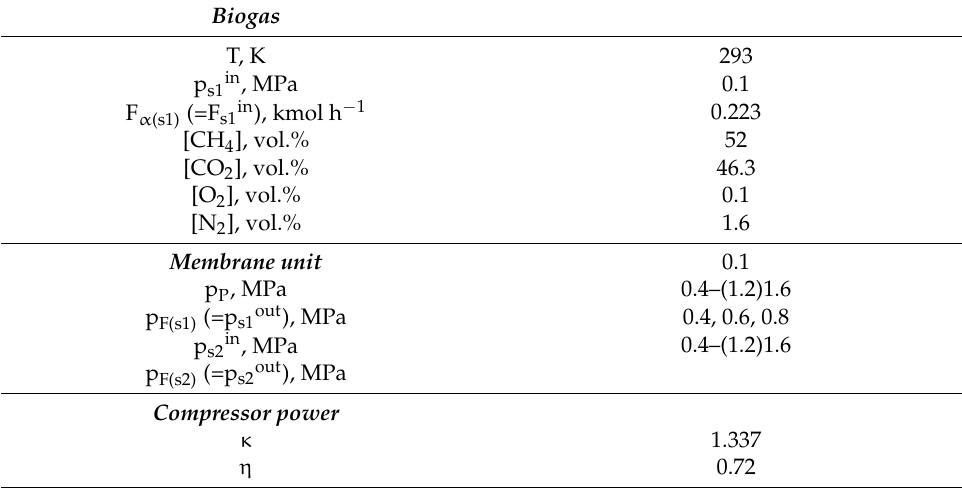
Table 3. Parameters used in